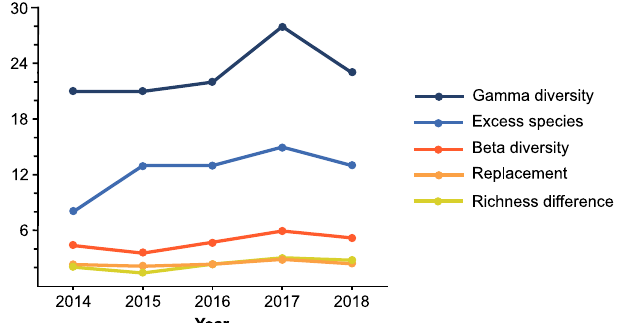
Figure 5. Changes of different diversity measures over the experimental years in the whole forest stand. 2014 was a pre-treatment year, 2015–2018 are experimental years after treatment implementation. Refer to Materials and methods for the description of diversity